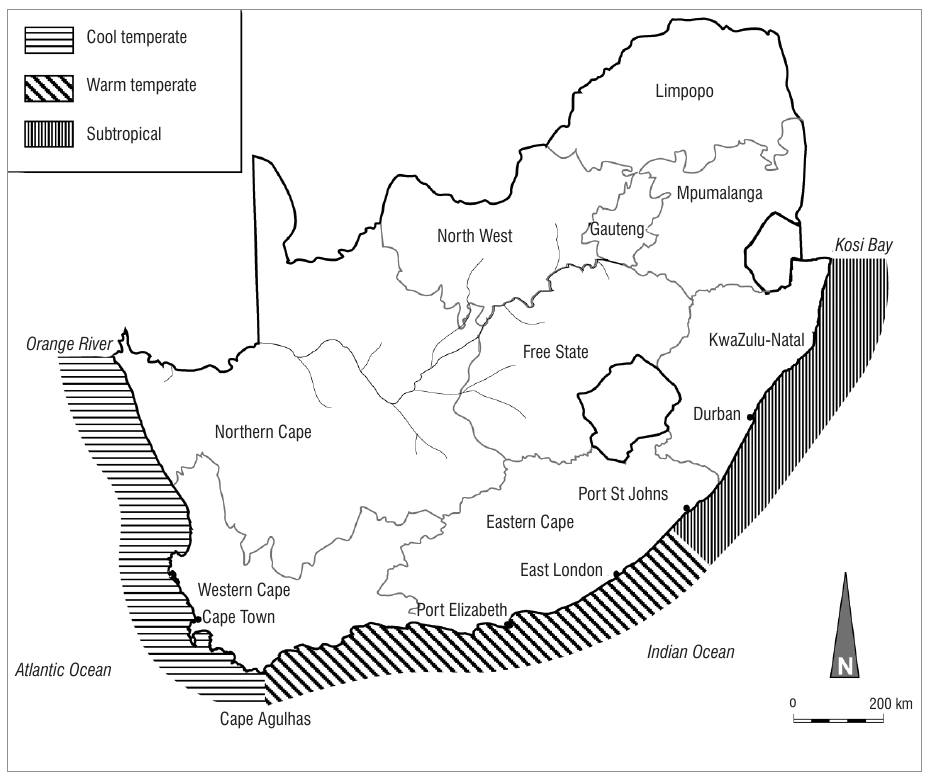
Figure 1: warm temperate and